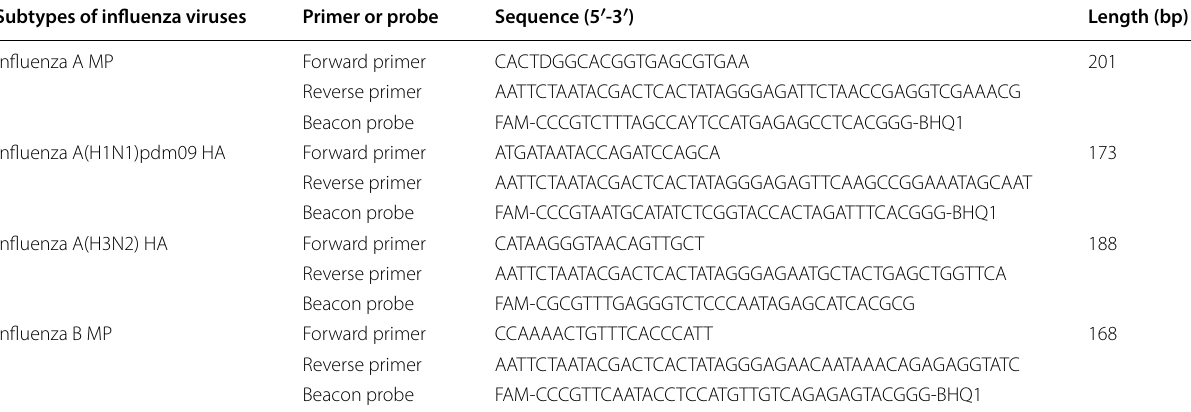
Four pairs of primers and molecular beacon probes specific for influenza A virus matrix protein (MP) gene, influenza A(H1N1)pdm09 hemagglutinin (HA) gene, influenza A(H3N2) HA gene, and influenza B virus MP gene were employed to detect four subtypes of influenza viruses